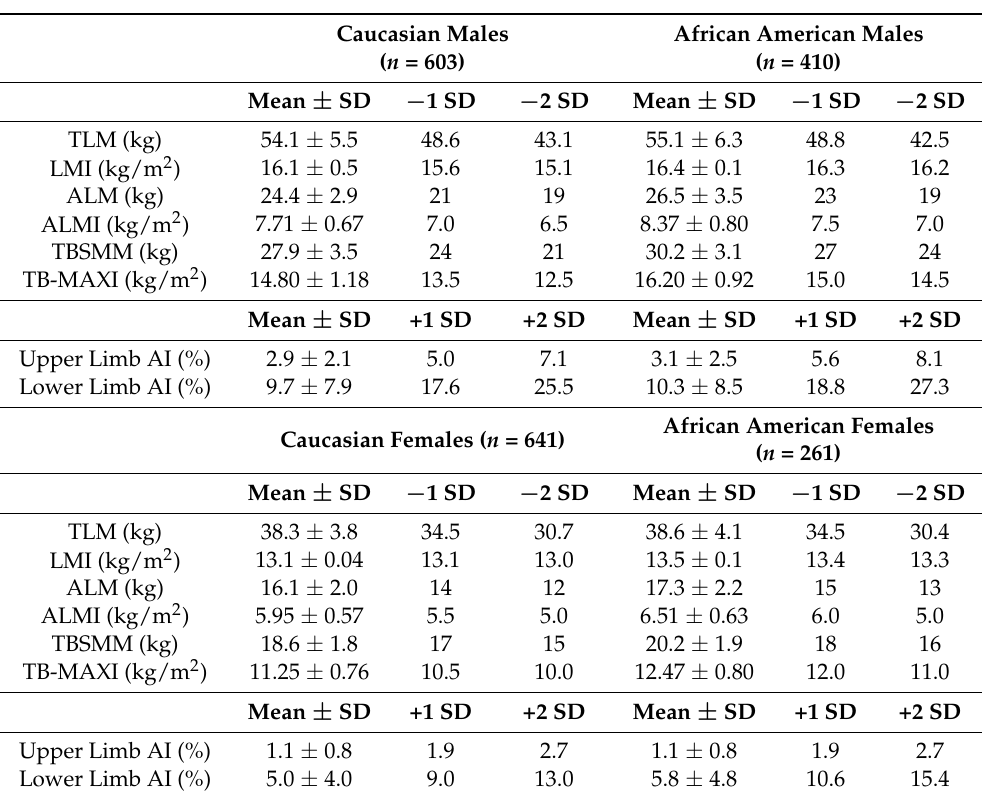
Table 3. Mean and standard deviation values for all DXA-derived indices of lean/muscle mass amount and distribution obtained in the reference population of 1915 young (aged 18–39 years) participants with normal body mass index (18.5–34.9 kg/m 2 ). TLM: total lean mass; LMI: lean mass index (total lean mass/height 2 ); ALM: appendicular lean mass; ALMI: appendicular lean mass index (appendicular lean mass/height 2 ); TBSMM: total body skeletal muscle mass (obtained with Equation #6 by Kim et al. [11]); TB-MAXI: total body muscularity assessment index (total body skeletal muscle mass/body surface area (obtained with equation by Du Bois and Du Bois [14]); AI: asymmetry